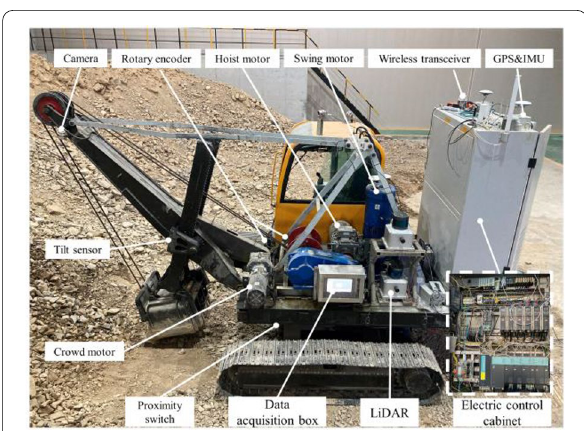
Figure 12 Experimental equipment: ECS prototype of the 1/7 scale model